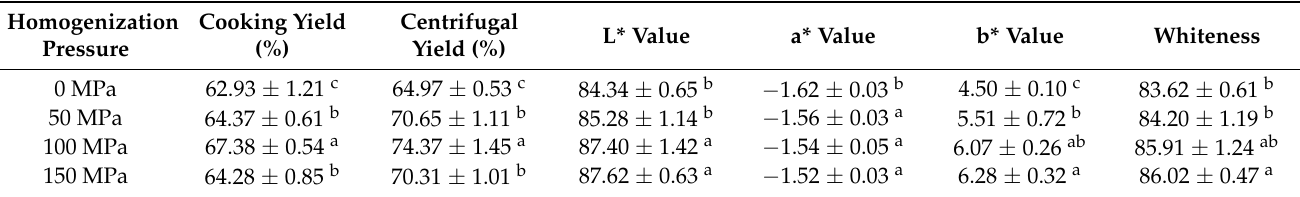
Table 1. The cooking yield (%), centrifugal yield (%), and color (L*, a* and b*, whiteness values) of pork myofibrillar protein with high-pressure homogenization-modified soy 11S